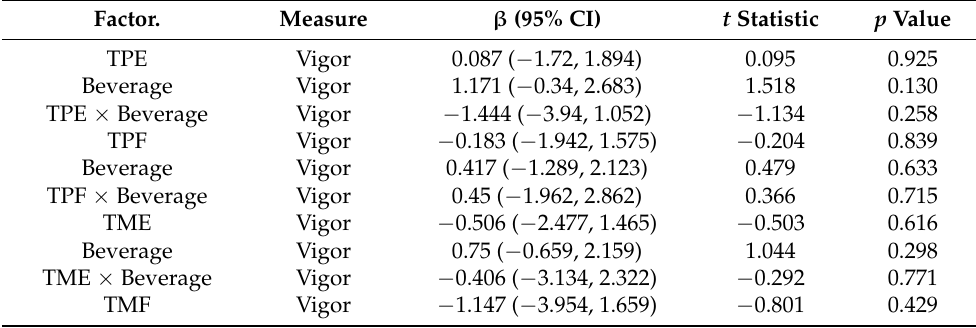
Table 4. Significant Analyses of Trait Mental and Physical Status According to Test Beverages.